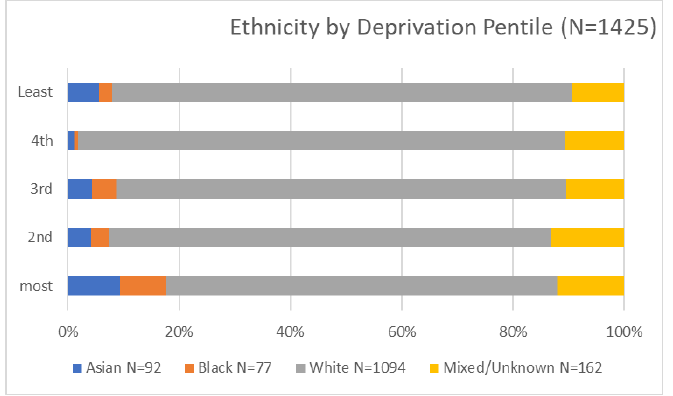
Figure 2. Graph reporting ethnicity of patients by deprivation percentile in IMD.